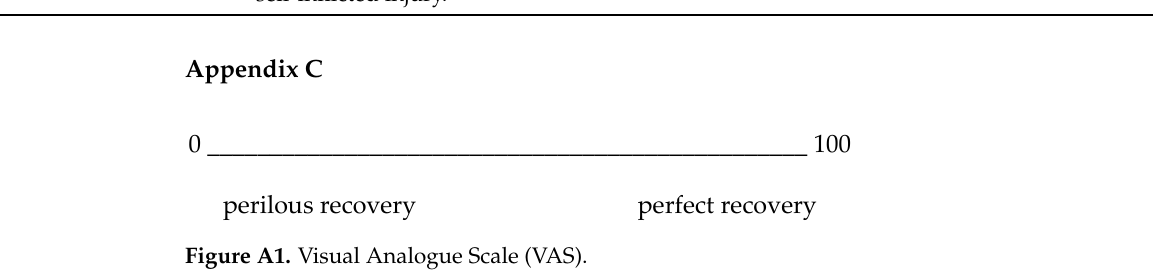
Figure A1. Visual Analogue Scale (VAS).